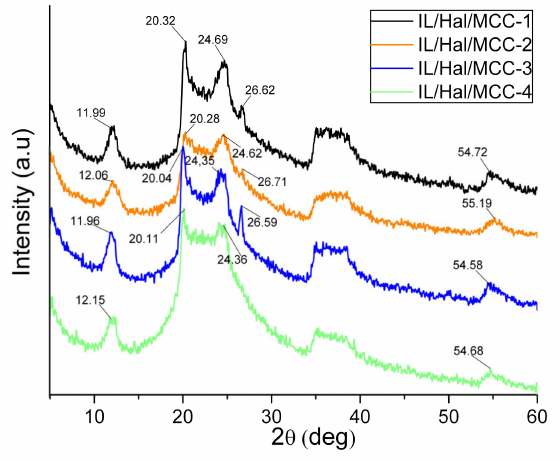
Figure 3. XRD patterns of IL/Hal/MCC ionogel samples.